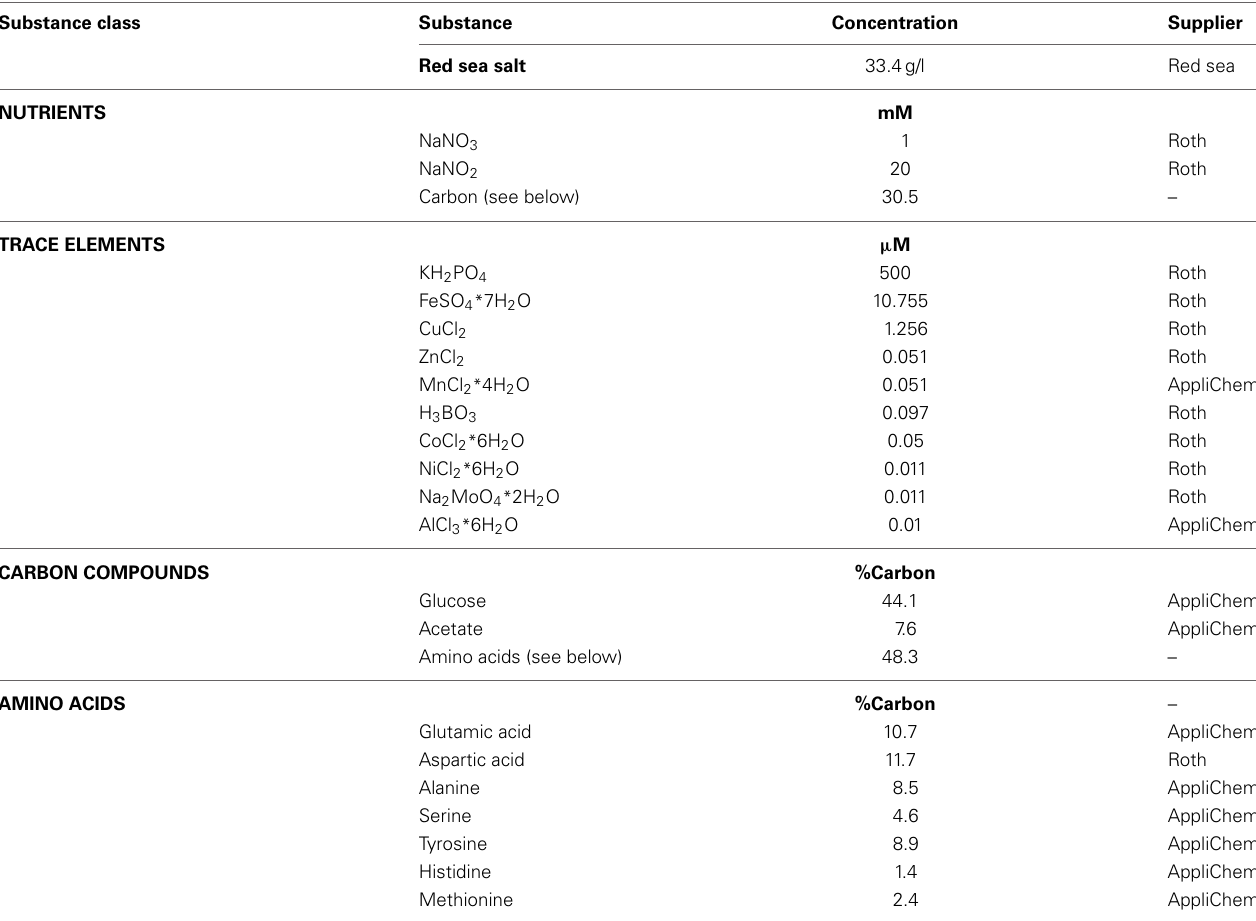
Table 1 | Medium composition for continuous